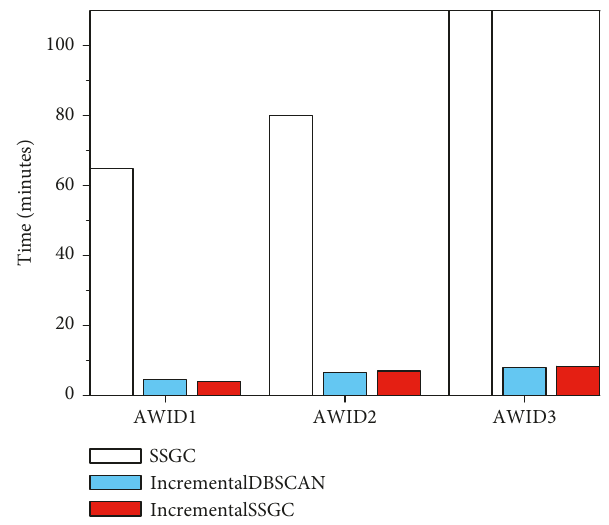
Figure 5: Running time comparison between IncrementalSSGC and IncrementalDBSCAN.